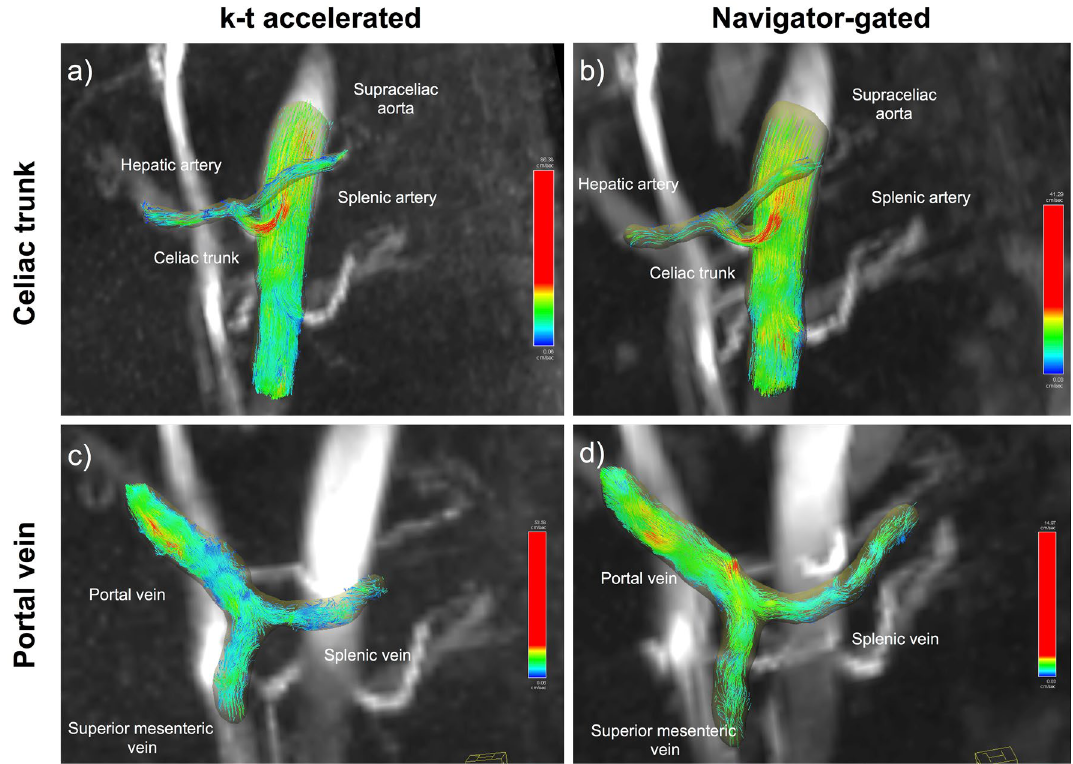
Figure 4. 60 year-old male with HCV cirrhosis and no portal hypertension (HVPG = 0 mmHg). Example of celiac trunk ( a , b ) and portal vein ( c , d ) segmentation with streamlines showing flow from the k−t accelerated ( a , c ) and the navigator-gated ( b , d ) acquisitions. Vessel depiction was of excellent quality for both acquisitions. ( a ) For the k−t accelerated acquisition, time-averaged velocity and flow in the hepatic artery were 7.3 cm/s and 2.3 ml/s, in the celiac trunk were 21.8 and 9.7 cm/s, and in the splenic artery were 4.8 and 2 cm/s. ( b ) For the navigator-gated acquisition, time-averaged velocity and flow in the hepatic artery were, and 5.9 cm/s